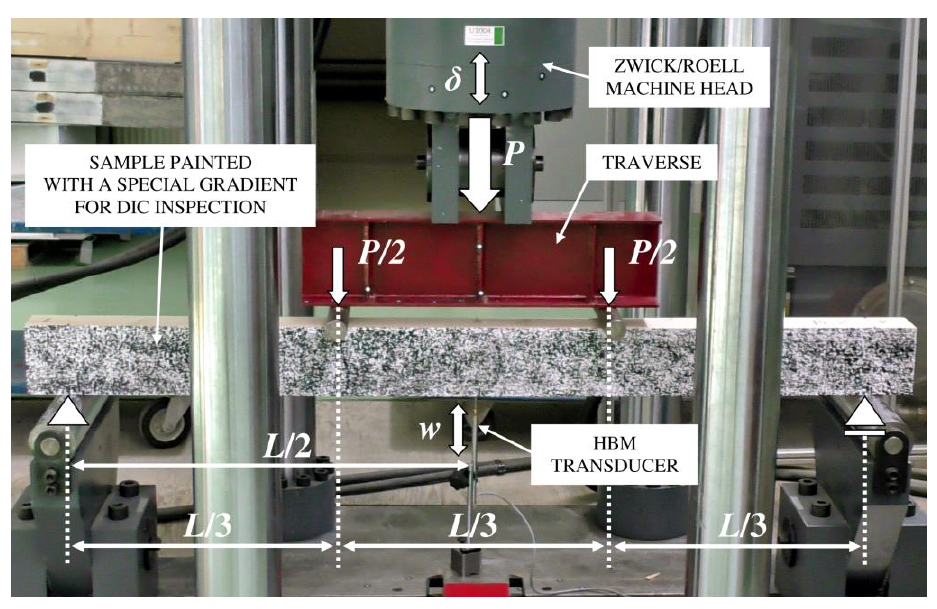
Figure 19. Laboratory setup.